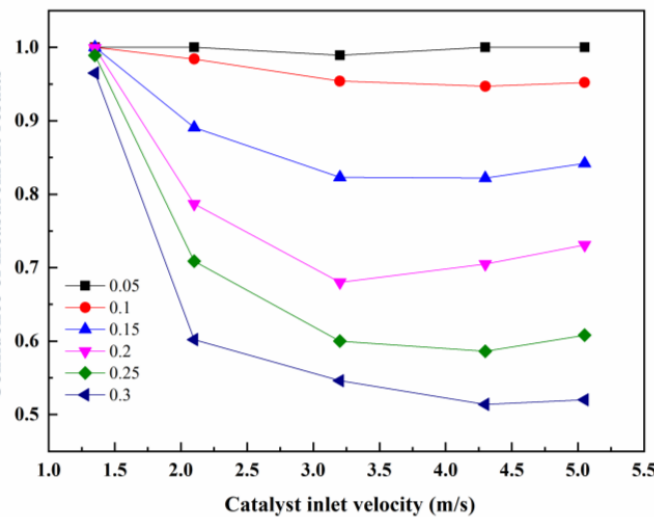
under different relative standard deviation of velocity at mean velocity 5.05 m/s.